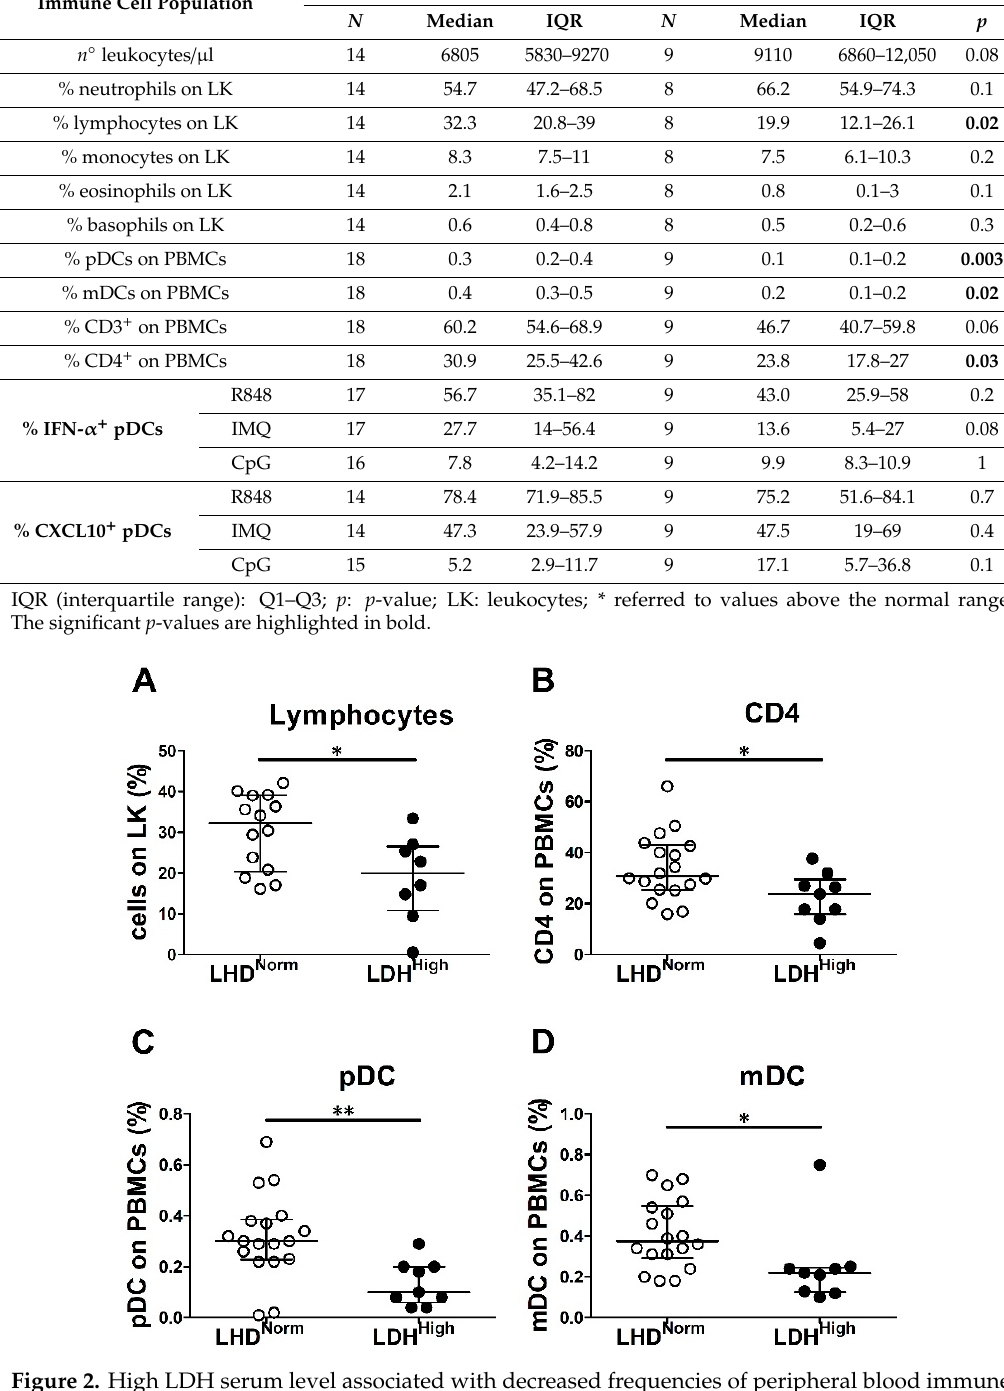
Figure 2. High LDH serum level associated with decreased frequencies of peripheral blood immune cells in MM patients. Immune cell populations were identified on whole blood samples of chemo-naïve MM patients by cell counts or flow cytometry. Scatter dot plot graphs represent the percentages of lymphocytes on total leukocytes (LK) ( A ), CD4 + T lymphocytes ( B ), pDCs ( C ), and mDCs ( D ) on total PBMCs. LDH levels are indicated as LDH Norm (for values within the normal range) and LDH High (for values greater than the normal range). Error bars represent the median with IQR ( n = 27). The